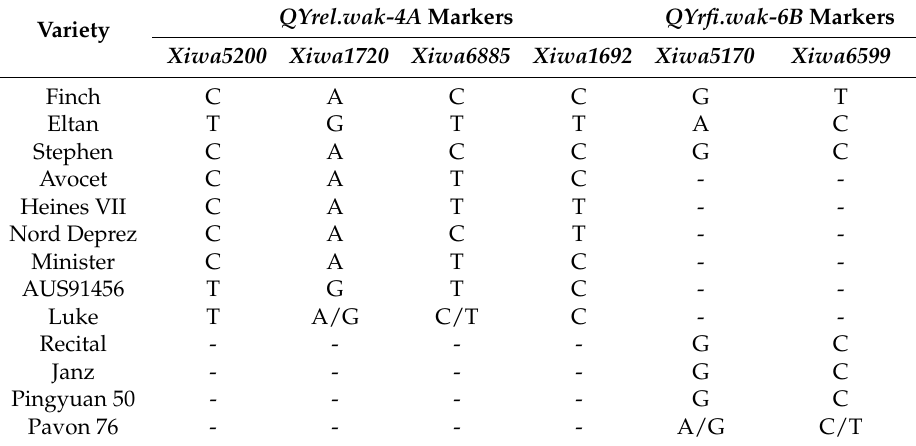
Table 2. ( a ) KASP markers associated with QYrel.wak-4A from Eltan as compared to varieties containing previously reported 4A quantitative trait loci (QTL); ( b ) KASP markers associated with QYrfi.wak-6B from Finch as compared to varieties containing previously reported 6B